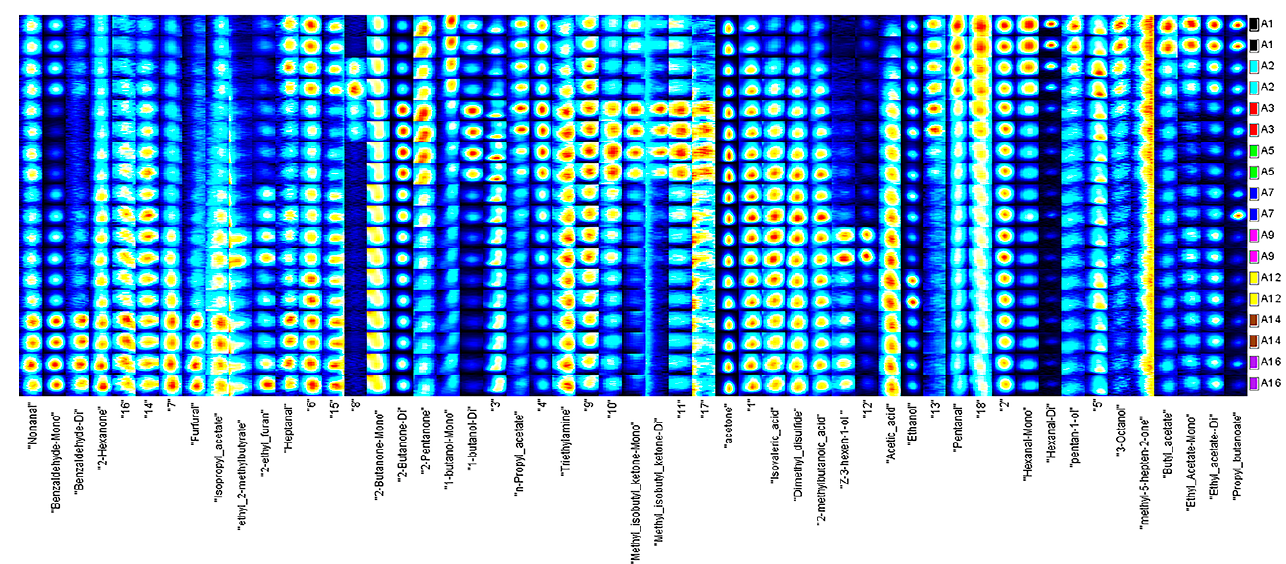
Figure 2. Gallery Plot fingerprint of different maturity rape honey samples.